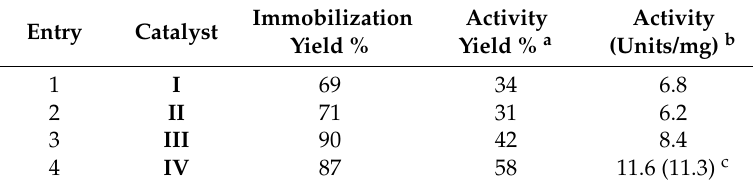
Table 3. Activity parameters of catalysts I – IV .